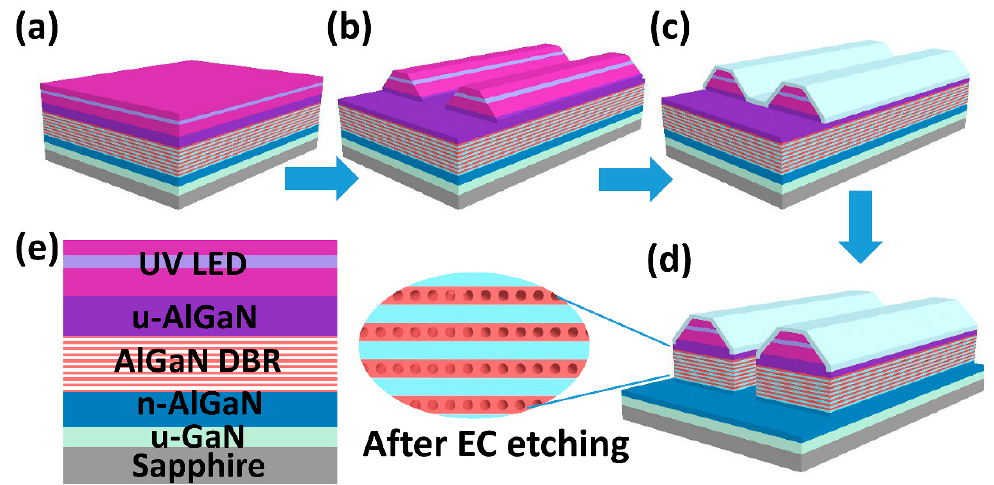
Figure 4. ( a – d ) Schematic diagrams of the two-step etching method with a SiO 2 SPL; ( e ) the epitaxial structure of the composite UV LED with embedded AlGaN DBR.